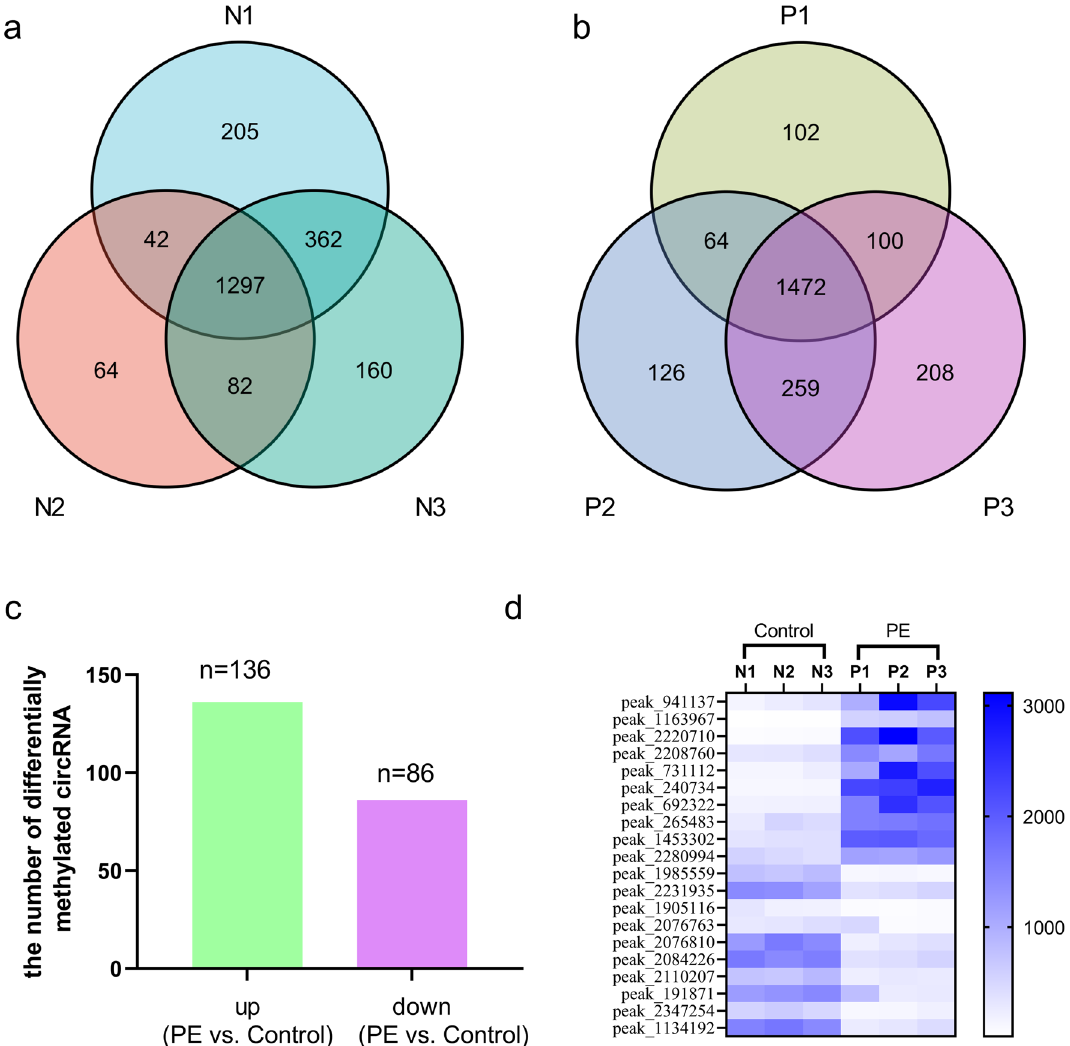
Figure 1. Results of m6A RNA sequencing data analysis with MACS and diffReps software. Venn diagram showing the overlap of m6A-modified sites on circRNAs among samples. The total number of m6A-modified sites on circRNAs in each group is shown ( a P1–P3 represent three PE subgroups. b N1–N3 represent three control subgroups. MACS software was used). There were 136 upregulated m6A-methylated circRNAs and 86 downregulated m6A-methylated circRNAs in PE placentas compared to control placentas ( c with diffReps Software, fold change > 2 and P < 10 –5 ). Hierarchical clustering analysis of the top twenty differentially expressed methylation sites ( d